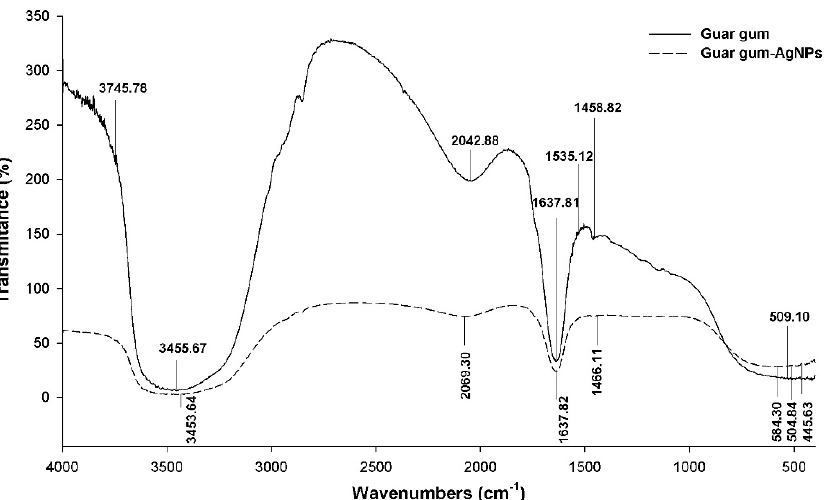
Figure 4. FTIR spectra of guar gum coating base (solid line) and guar gum-AgNPs (dashed line).